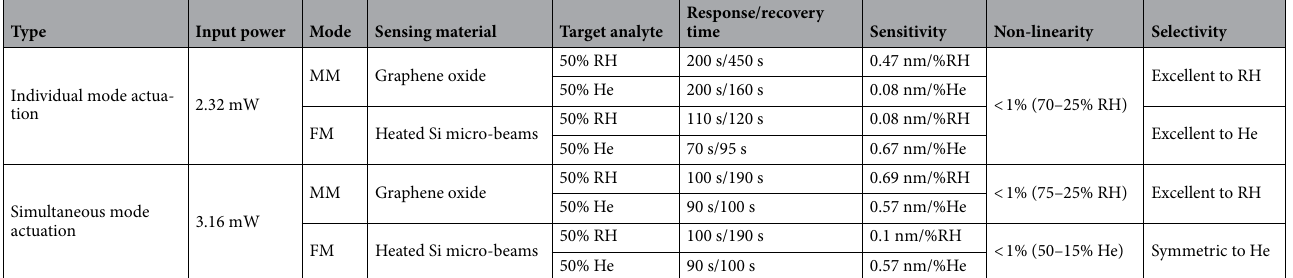
Table 1. Summary of sensing results obtained with individually and simultaneously actuated vibration modes.